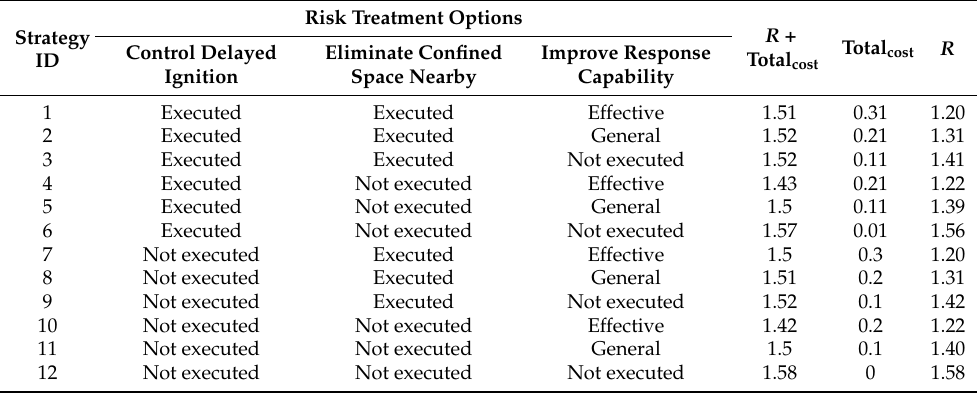
Table 8. Risk treatment options and corresponding modeling results after